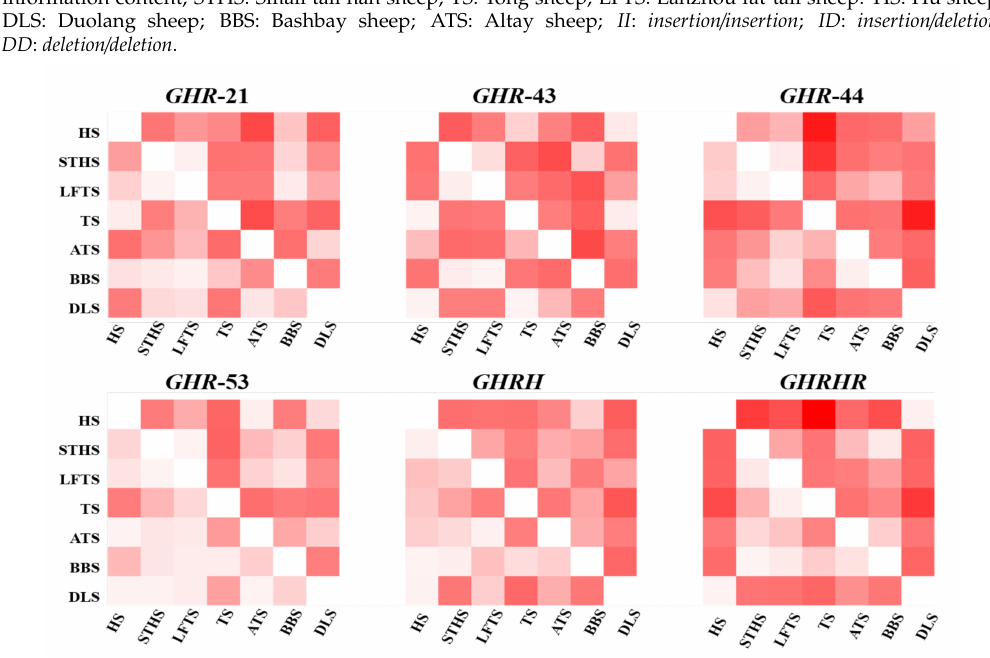
Figure 2. Di ff erence analysis of InDel (insertion / deletion) distribution among